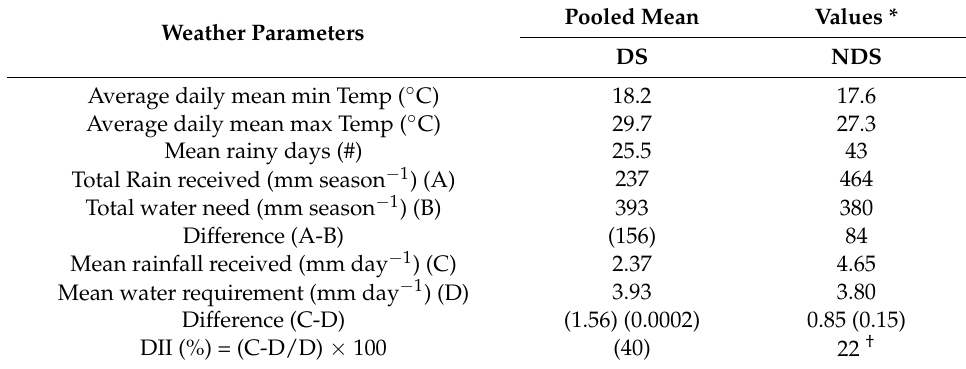
Table 1. Climate information in as determined in the two drought conditions in 2014, Uganda. Weather